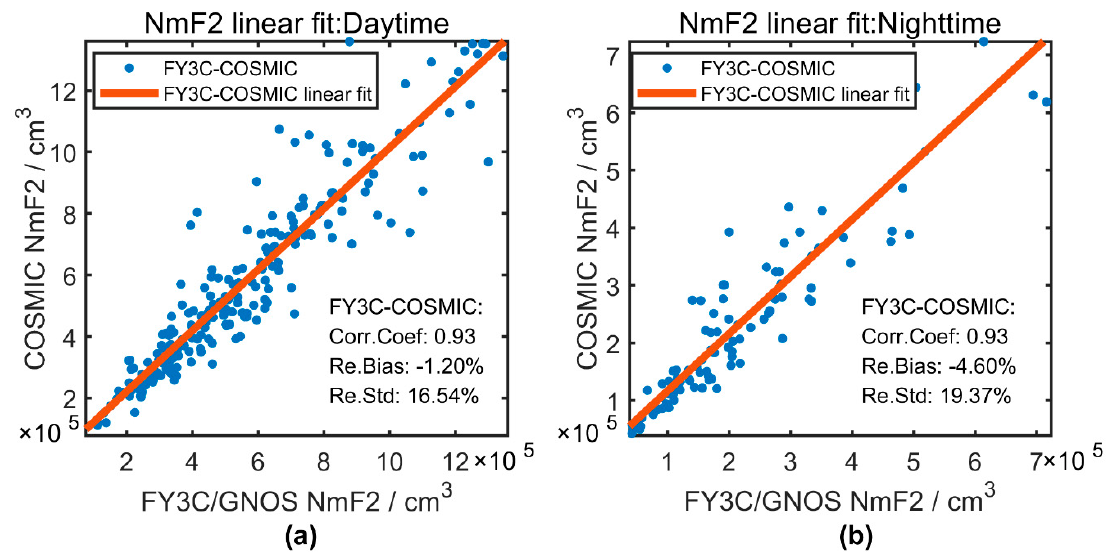
Figure 3. Linear fits of NmF2 between FY3C / GNOS and COSMIC at daytime and nighttime during 2016.035 and 2017.035: ( a ) the linear fit of NmF2 between FY3C / GNOS (horizontal axis) and COSMIC (vertical axis) at 0600–1800LT, corresponding to daytime; ( b ) the linear fit of NmF2 at 1800–0600LT, corresponding to nighttime. The correlation coe ffi cient of NmF2 data pairs, the bias, and std of relative errors of matched NmF2 data pairs at daytime and nighttime are presented in the bottom right corner of ( a ) and ( b ), respectively.